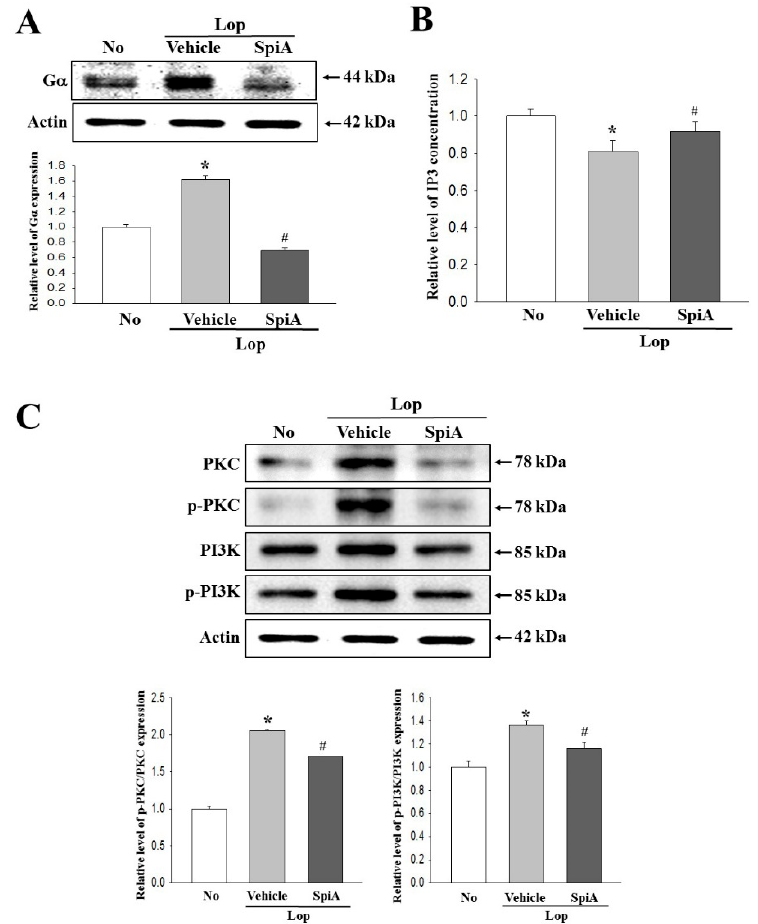
Figure 5. mAChR downstream signaling pathway in the colon treated with SpiA. ( A ) The expression of G α in the mAChR-signaling pathway were measured by Western blot analysis using HRP-labeled anti-rabbit IgG antibody. Five to six mice per group were used in preparation of total lysate and specific protein level was assayed in duplicate in each test. ( B ) After collection of the colon from mice of each group, tissue lysates were prepared as described in the materials and methods. The IP3 concentration in the total cell lysate was measured using an ELISA kit that detects IP3 at 5 pg/mL to 1000 pg/mL. Five to six mice per group were used in preparation of total lysate and IP3 level was assayed in duplicate in each test. ( C ) The expression of several related proteins, including PKC, p-PKC, PI3K and p-PI3K in the mAChR M2 and M3 signaling pathway were measured by Western blot analysis using HRP-labeled anti-rabbit IgG antibody. After determining each band intensity using an imaging densitometer, the relative levels of the four proteins were calculated based on the intensity of actin. Five-to-six mice per group were used in preparation of total lysate and specific protein level was assayed in duplicate in each test. Data are reported as the mean ± SD. *, p < 0.05 compared to the untreated group. # , p < 0.05 compared to the Lop + Vehicle treated group. No, Untreated group; Lop, Loperamide; SpiA, Spicatoside A; IP3, Inositol triphosphate, mAChR; Muscarinic acetylcholine receptors, HRP; Horseradish peroxidase, PKC; Protein kinase C , PI3K, Phosphoinositide 3-kinases.